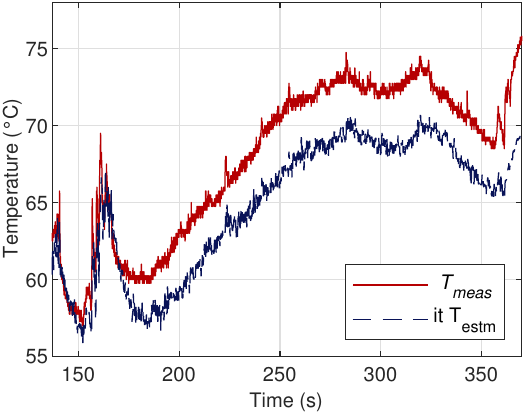
Figure 17. Measured temperatures and simulated temperatures of the smartphone while put in a heated environment. Divergence starts around t =